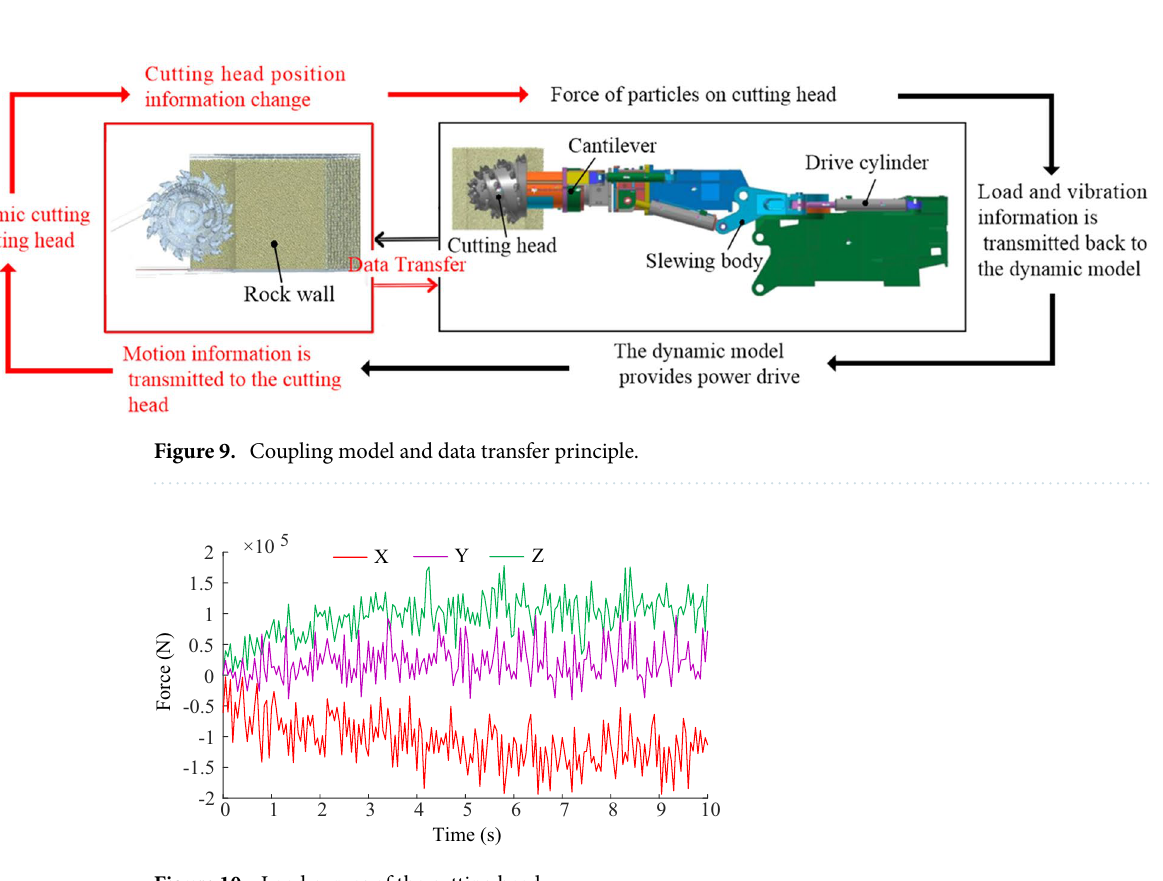
Figure 8. Cutting diagram: ( a ) equidistance; ( b ) equidifference.